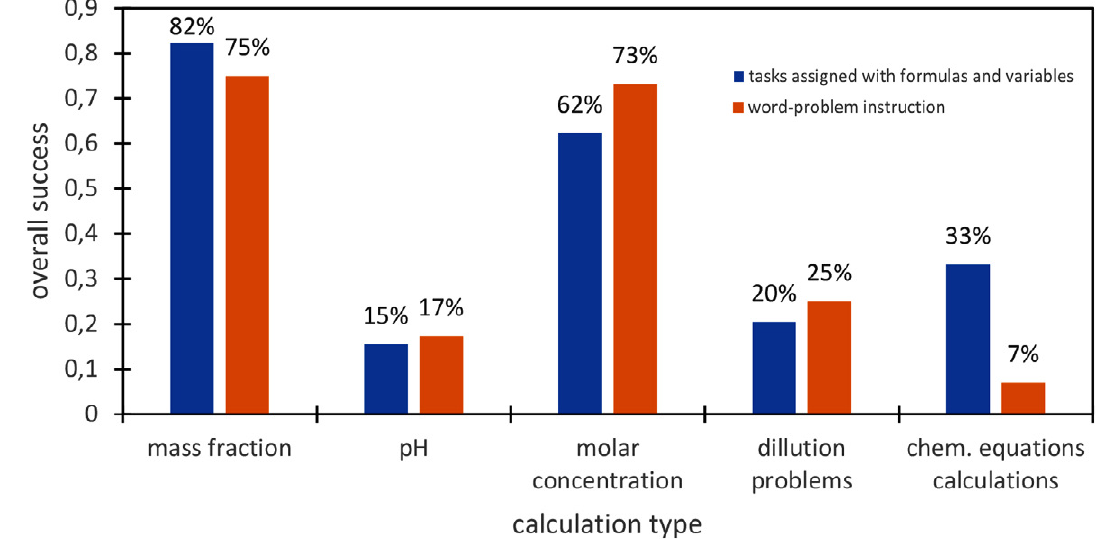
Figure 1. Students’ success in solving individual types of chemical calculations depending on the type of